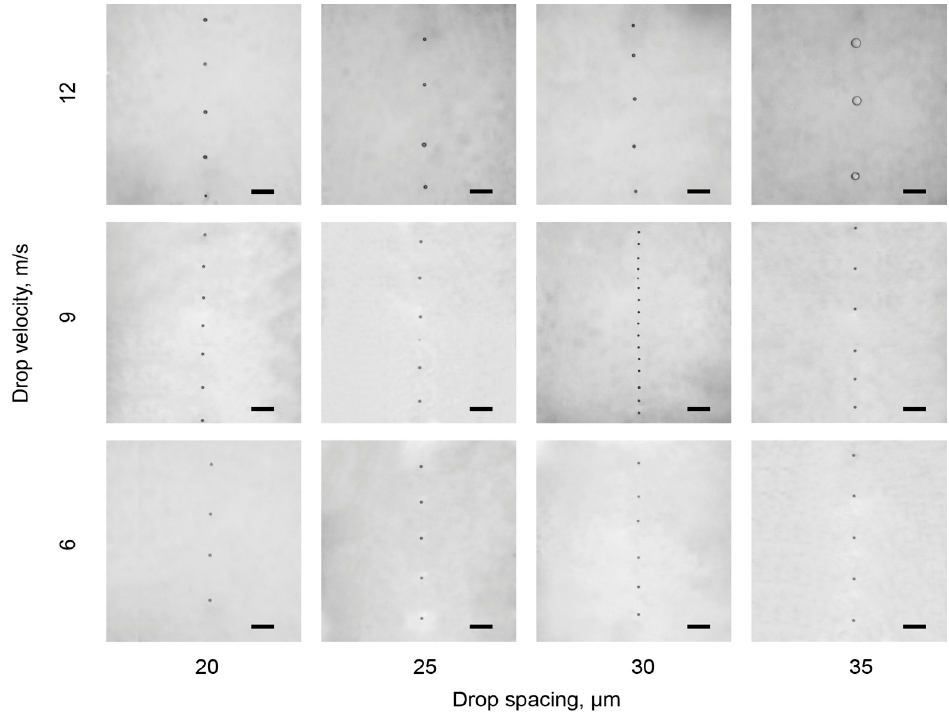
Figure A1. Array of optical images of a 1 pxl line printed on uncured PDMS as a function of drop spacing and velocity. The scale bar is 100 µm.